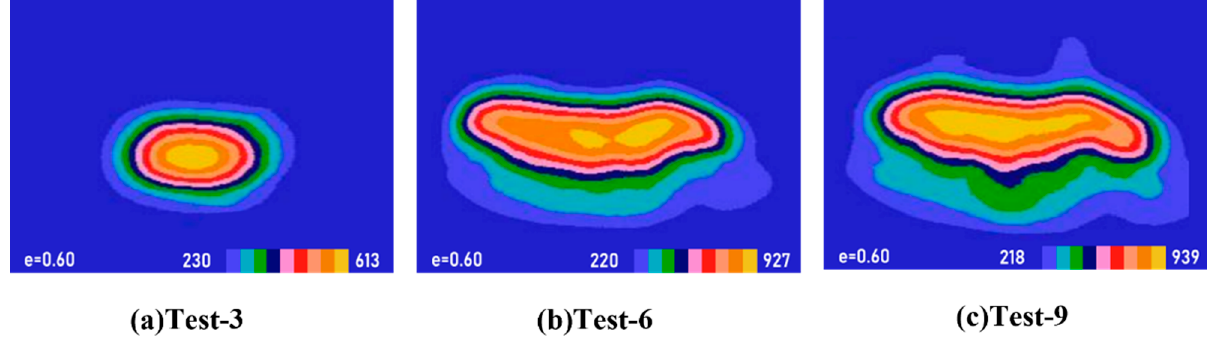
Figure 10. The surface temperature changes of Test-3, Test-6, and Test-9 in the smoldering stage (where ( a ) is a coal pile of 40 cm diameter and 6 cm thickness, ( b ) is a coal pile of 60 cm diameter and 6 cm thickness, ( c ) is a coal pile of 80 cm diameter and 6 cm thickness).